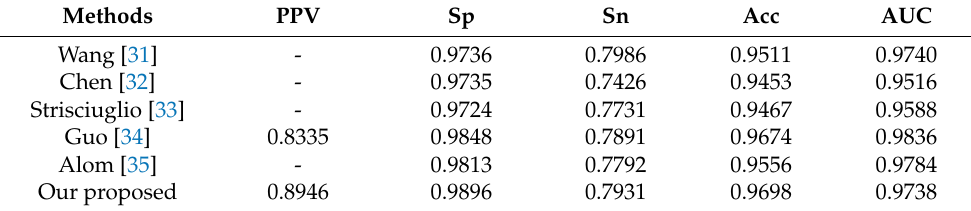
Table 1. Comparison of performance data between different literature